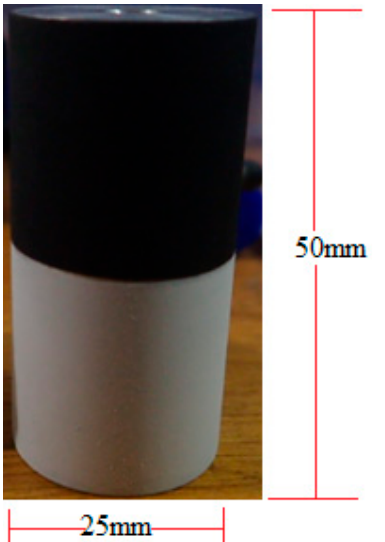
Figure 2. Cylinder coated with polytetrafluoroethylene (PTFE) coating (bottom) and graphite coating (top). Each coated cylinder was rotated at 15 rpm in supercooled airflow in order to create a uniform